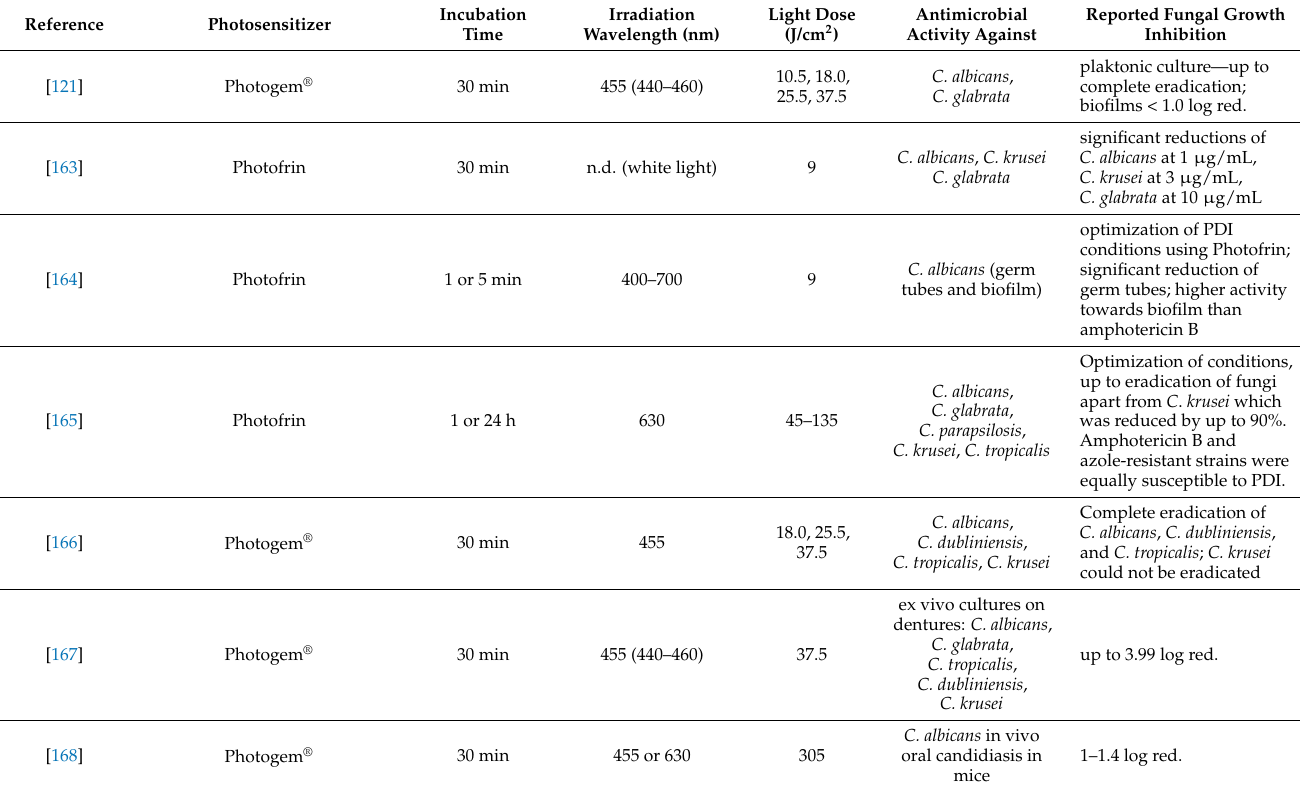
Table 4. Porphyrins—photodynamic antimicrobial activity and